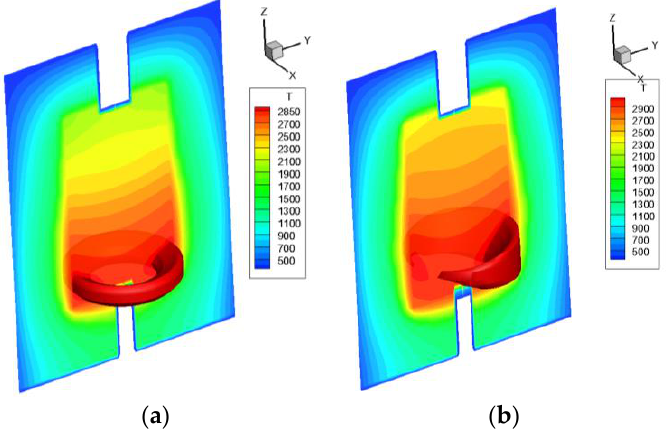
Figure 9. Temperature field at I = 1250 A and F = 16 kHz. ( a ) Axisymmetric coil; ( b ) spiral coil.